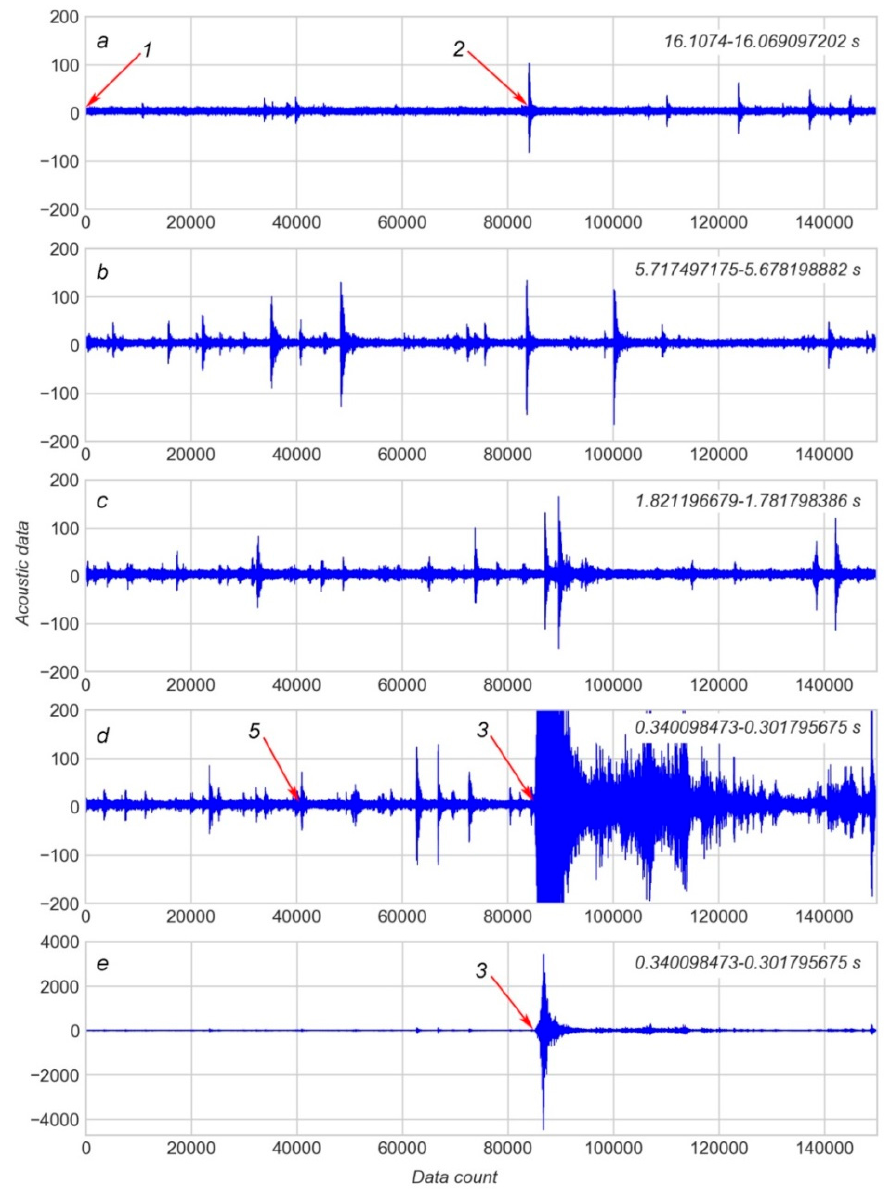
Figure 1. Plot of acoustic data in the 8th “earthquake” cycle from the dataset provided by [25]: ( a )—the beginning of the seismic cycle; ( b , c )—middle parts of the seismic cycle; ( d , e )—part of the seismic cycle with the earthquake (EQ) event at different levels of magnification. Arrows are explained in the text.